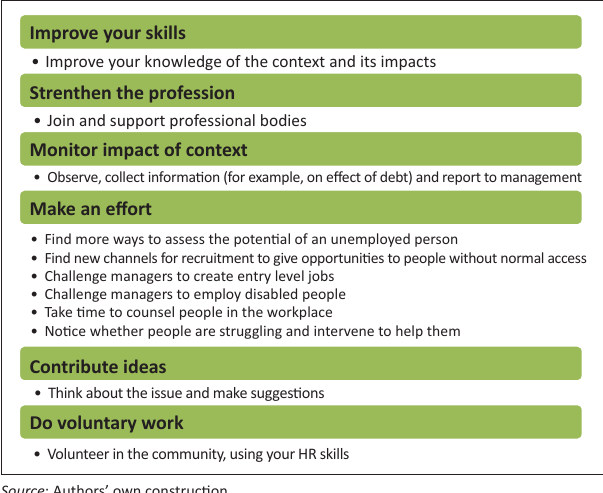
FIGURE 7: Possible elements of a response at an individual HR practitioner